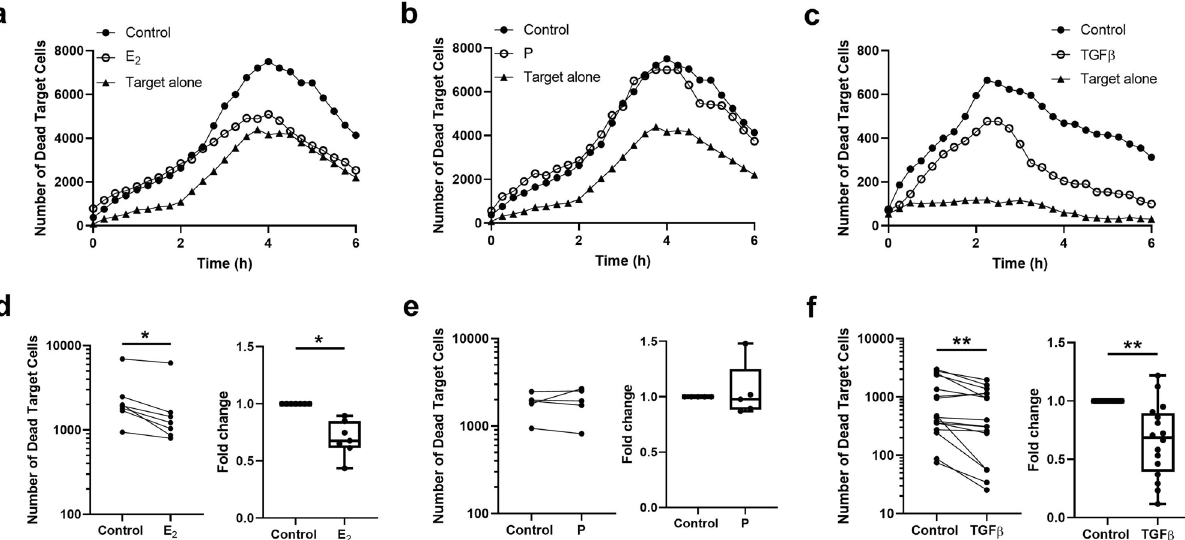
Figure 1. Effect of E 2 , P and TGFβ on endometrial CD8+T cells cytotoxicity. Purified endometrial CD8+T cells (effector cells, E) were pre-treated with E 2 (5 × 10 −8 M), P (1 × 10 −7 M) for 48 h or TGFβ (10 ng/ml) for 2 h before co-culture with CFSE-stained allogeneic blood CD4+T cells (target cells, T) using a E:T ratio of 1:1. Cytotoxicity was measured over time by using quantitative time-lapse microscopy. Representative time-course of the kinetics of cytotoxicity over a period of 6 h in the absence (control) or presence of E 2 ( a ), P ( b ) and TGFβ ( c ). Target alone are allogeneic blood CD4+T cells. Comparison of E 2 ( d , n = 7), P ( e , n = 5) and TGFβ ( f , n = 16) treatment in the mean number of dead target cells (left graph) and fold change in the mean number of dead target cells after E 2 , P and TGFβ treatment compared to control (right graph). Each dot represents a different patient. Min to Max ( d – f , right graph) are shown. * P < 0.05; ** P < 0.01; Wilcoxon matched-pairs signed rank cell populations. Mixed cell suspensions from EM tissues were incubated with E 2 for 48 h prior to measuring granular content by flow cytometry. Figure 3a shows a representative example of the content of perforin, GZA and GZB before and after treatment with estradiol. As shown in Fig. 3b, using matched samples from multiple patients, E 2 significantly suppressed the content of perforin and GZA (MFI) in both tissue resident (CD103+) and non-resident (CD103−) CD8+T cells. In contrast, E 2 had no effect on GZB. Interestingly, as seen in Fig. 3c, E 2 reduced the percent positive CD103+and CD103−CD8+T cells containing perforin but had no effect on the percentage of cells that were GZA or GZB positive. These findings suggest that E 2 regulates both CD103+and CD103−CD8+T cells and that suppression of the levels of cytotoxic molecules is unique in that each of the cyto- toxic responses to E 2 are separate and distinct. This is consistent with our previous results that menopausal status equally affects resident and non-resident T cells 11 , suggesting that tissue residency does not modify sensitivity to hormonal control.